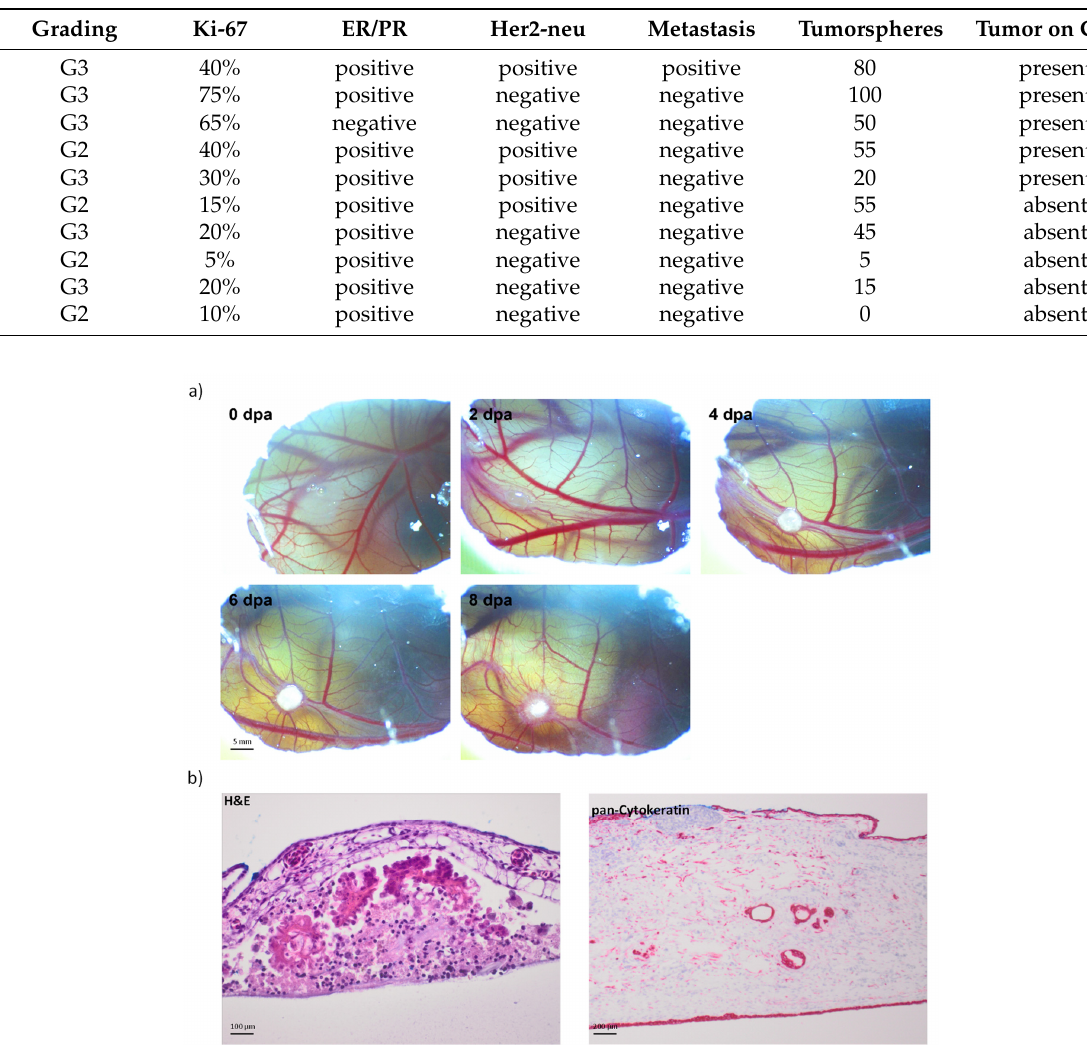
Figure 5. ( a ) Development of a microtumor from tumorspheres of a breast cancer patient on CAM membrane. Scale bar = 5 mm; magnification ×20. ( b ) H&E and pan-cytokeratin staining of a CAM xenograft developed from tumorspheres in light microscopy. Scale bar = 100 µ m for H&E, scale bar = 200 µ m for pan-cytokeratin; magnification ×